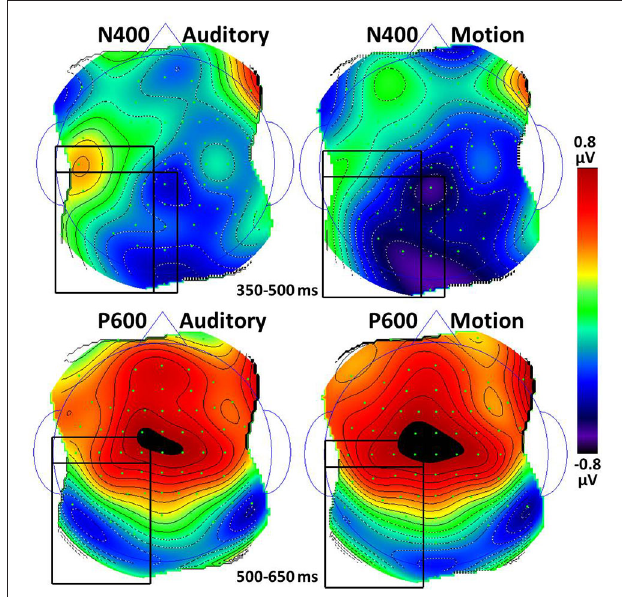
FIGURE 3 | Topographic maps of the N400 and P600 responses to the last word in auditory and motion sentences (anomalous excluded) . For the N400, black rectangles indicate the Left Center, Left Posterior, and Center Posterior regions which had statistical differences between auditory and motion conditions, p s < 0.05. For the P600, black rectangles indicate the Left Center and Left Posterior regions which had differences approaching significance ( p s < 0.18); the location × condition interaction was